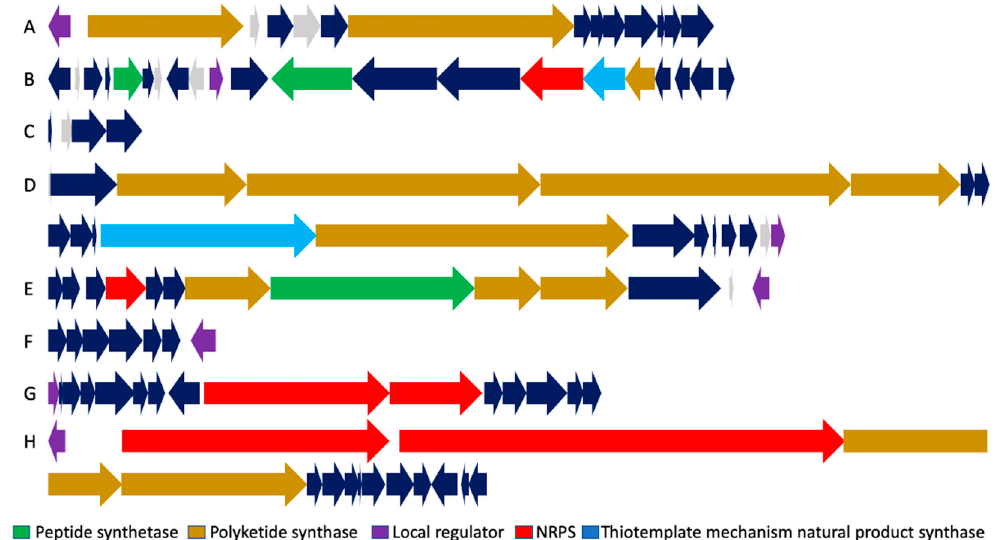
Figure 2. Organization of biosynthetic gene clusters. ( A ) Malleilactone. ( B ) Bactobolin. ( C ) Capistruin. ( D ) Thailandamide. ( E ) Burkholdacs. ( F ) Pyoverdine. ( G ) Ornibactin. ( H ) Thailanstatin. Genomic loci and individual gene annotations correspond to B. thailandensis E264 and are obtained from the Burkholderia Genome Database (https://www.burkholderia.com), except for the Ornibactin biosynthetic gene cluster ( B. cenocepacia J2315; Burkholderia Genome Database [22] ) and the Thailanstatin gene cluster ( B. thailandensis MSMB43; NCBI GenBank JX307851.1).